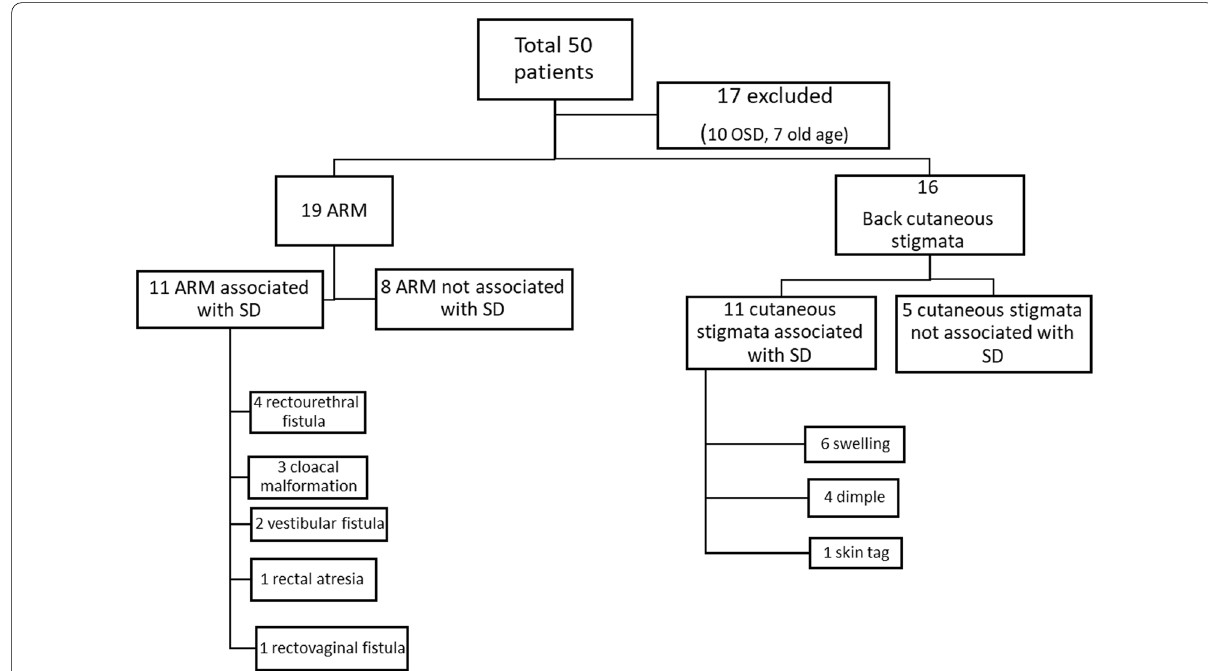
Fig. 1 Diagnostic flow chart of the study population. Note 2 patients were presented with both ARM and back cutaneous stigmata. ARM anorectal malformation, SD spinal dysraphism, OSD open spinal